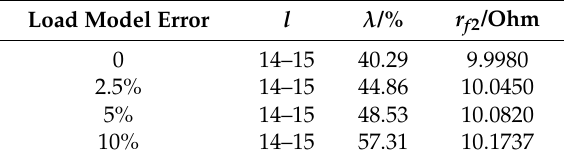
Table 19. Locating results of Strategy 1 with different errors of loads model for Case